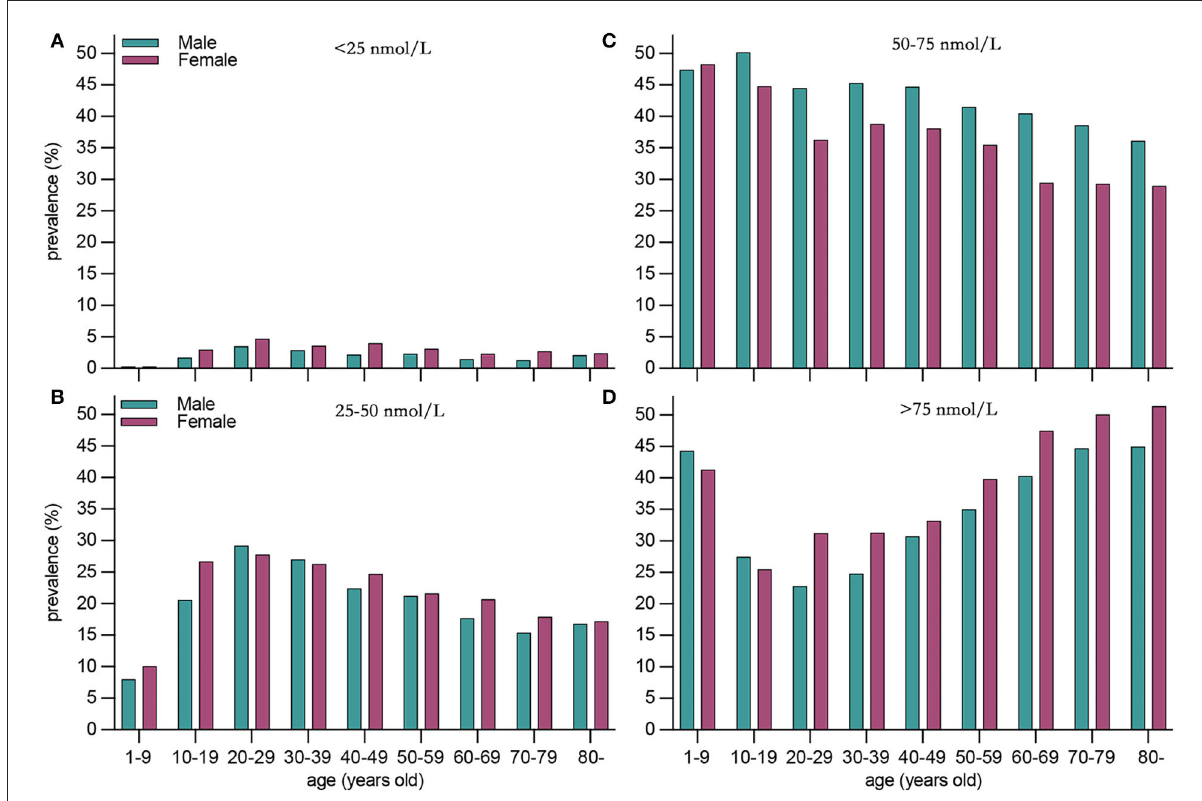
FIGURE1 Weighted prevalence of serum 25(OH)D 75 nmol/L in the United States between 2001 and 2018 by sex and age. (A) < 25 nmol/L, (B) < 25–50 nmol/L, (C) 50–75 nmol/L, and (D) >